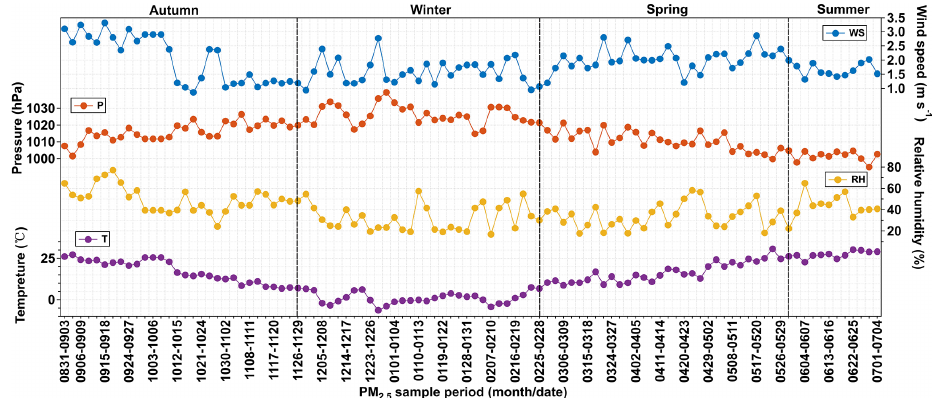
Figure 2. Temporal variations of ambient temperature ( T ), atmospheric pressure ( P ), wind speed (WS) and relative humidity (RH) in Tianjin from September 2018 to July